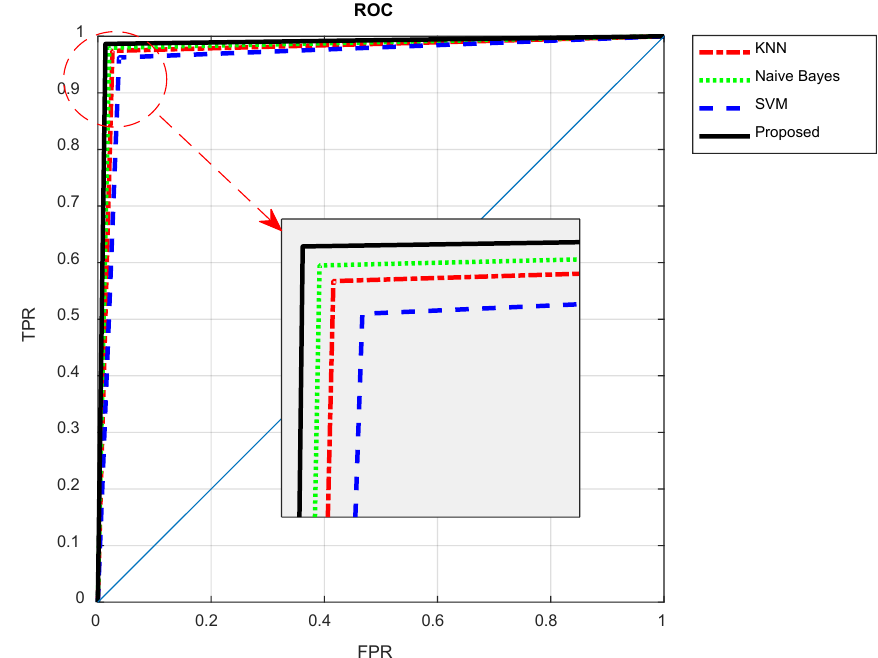
Figure 11. The ROC curve of the proposed method compared to other algorithms .